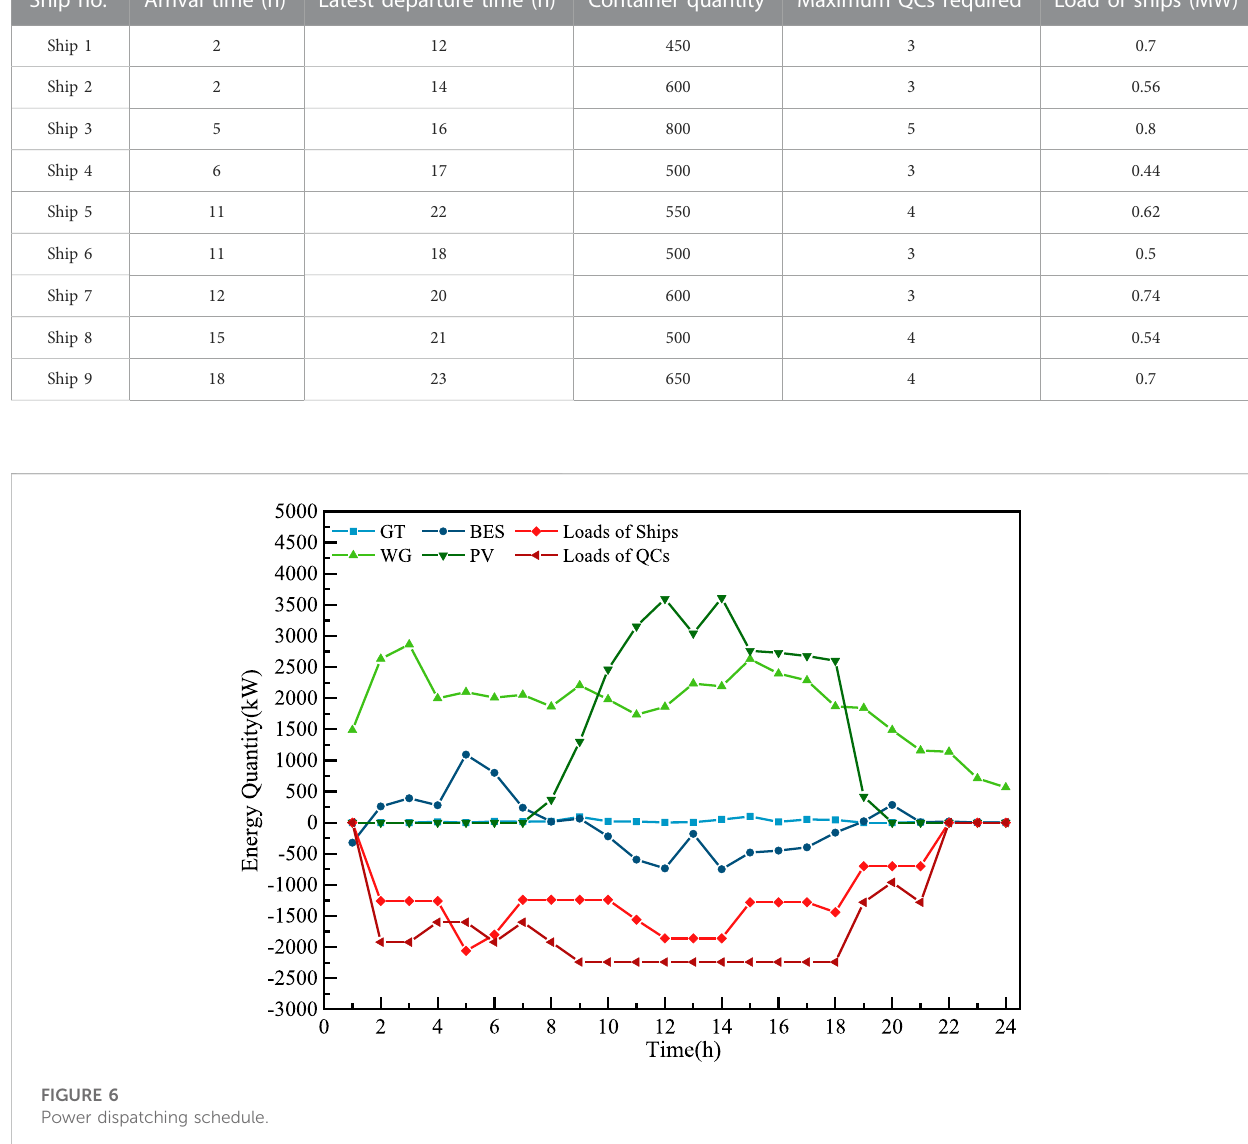
TABLE 3 Parameters of the port logistics system. Ship no.